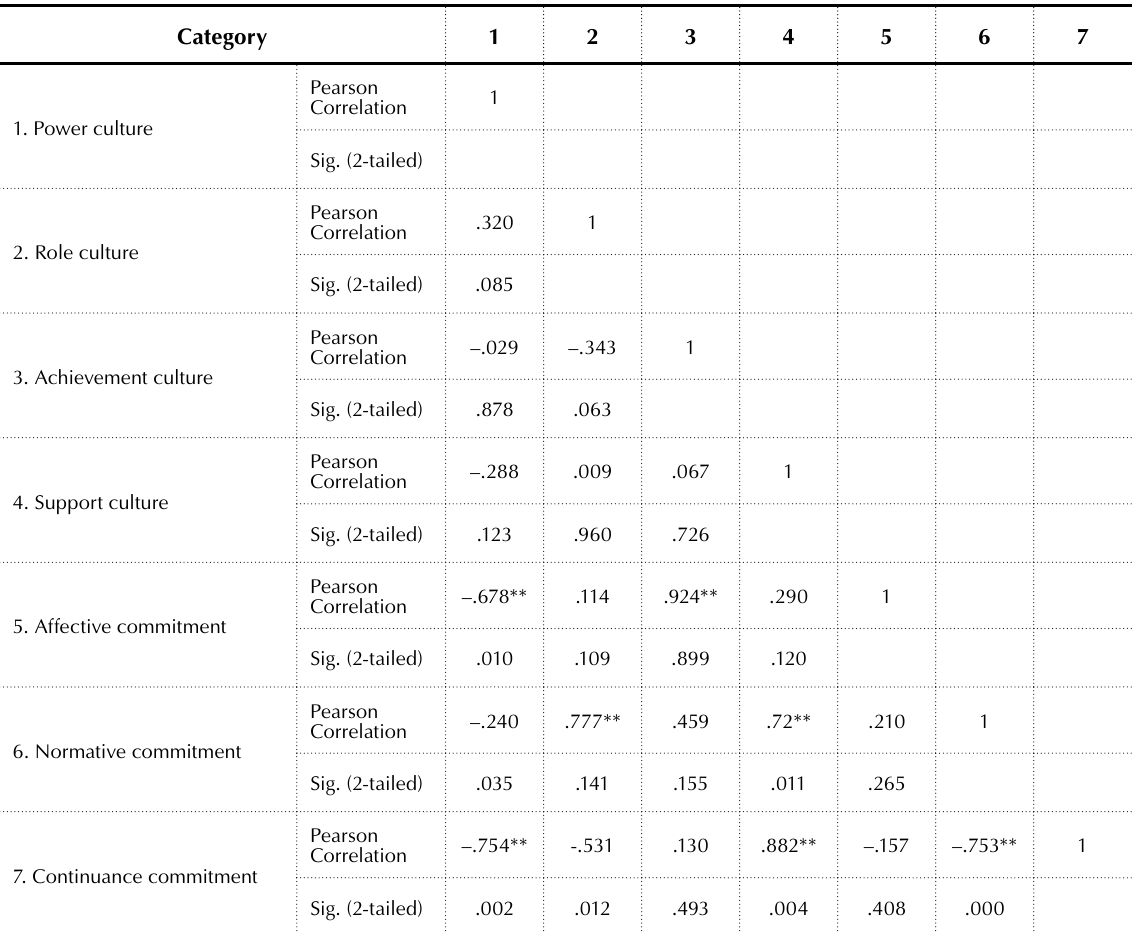
Table 2. Inter correlation matrix of scores on the organizational culture typologies and organizational commitment